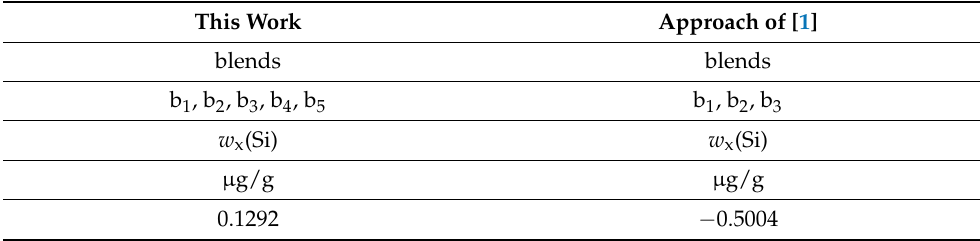
Table 7. A representative result of mass fractions w x (Si) determined using the approach of this work (using all five blends) and the approach of [1] (using the three triple blends: b 1 , b 2 , b 3 ; b 2 , b 3 , b 4 ; and b 3 , b 4 , b 5 ). Only the combination of b 2 , b 3 , b 4 (the inner blends) yielded a reasonable numerical result. This